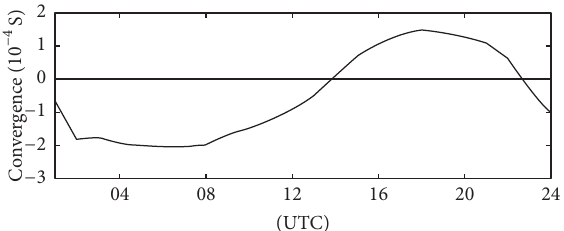
Figure 9: Daily cycle of sea breeze convergence over the surface for the 21